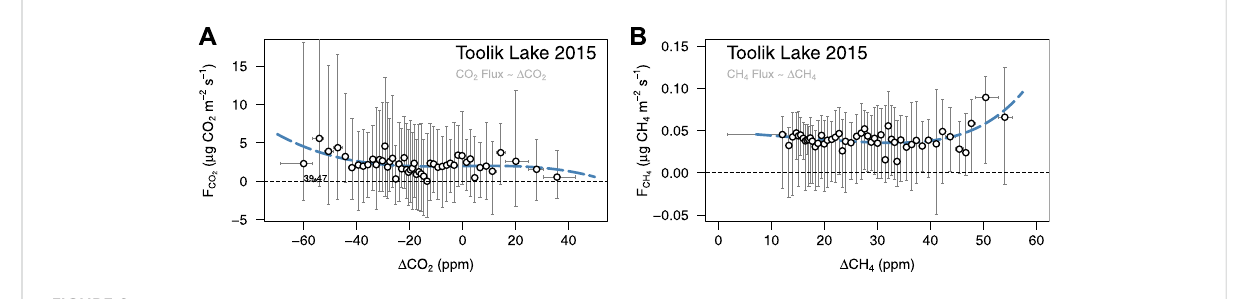
FIGURE 9 Relationshipsbetweenmeasurementsofthewater – air (A) CO 2 gradient( Δ CO 2 )and (B) CH 4 gradient( Δ CH 4 )andtheirrespective fl uxacrossthe water interface. Positive Δ values indicate that the mixing ratio in water is above the equilibrium mixing ratio in the